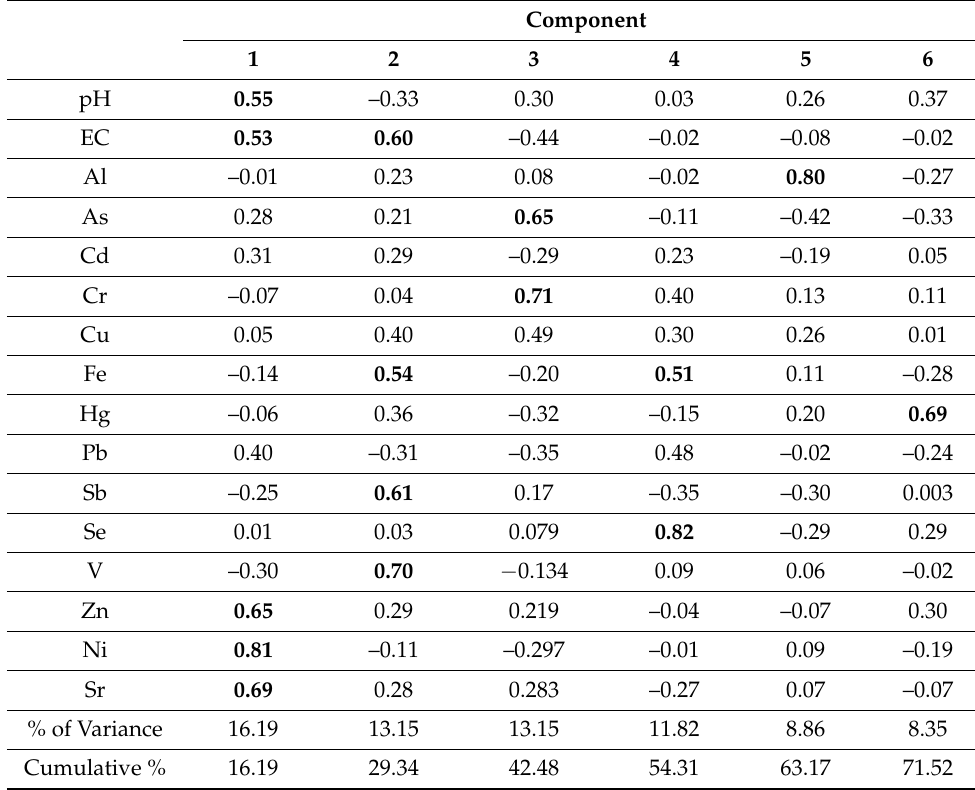
Table 5. Principal component loadings along with six variances for the